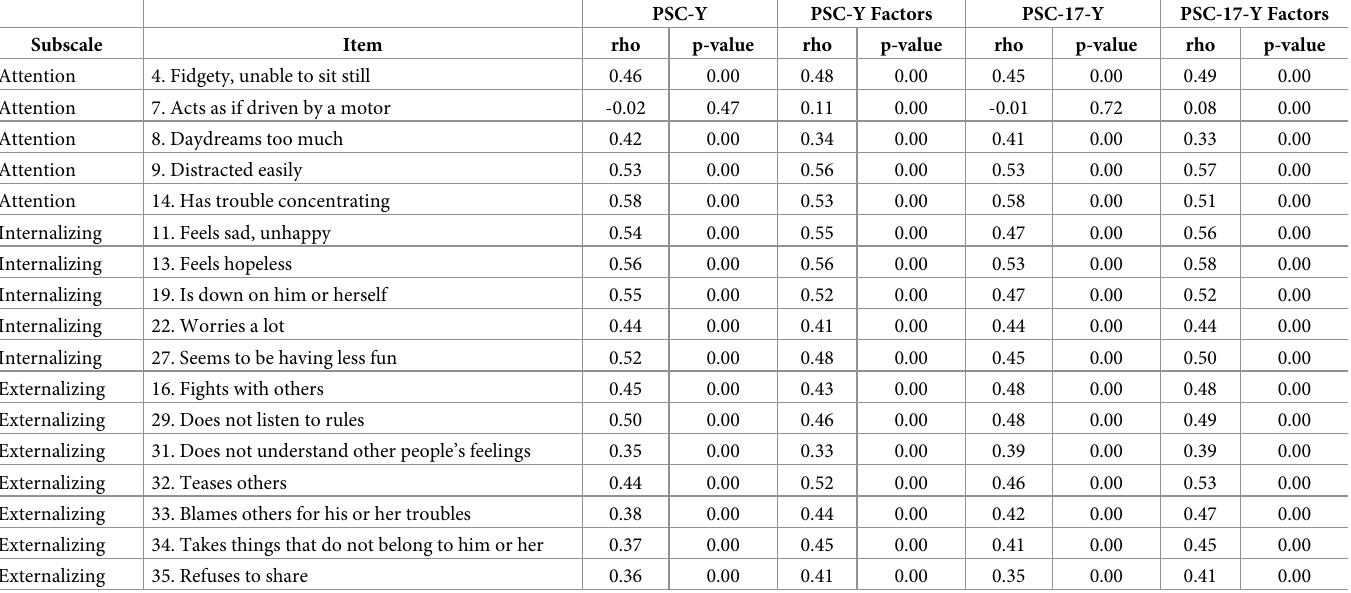
Table 2. Description of items